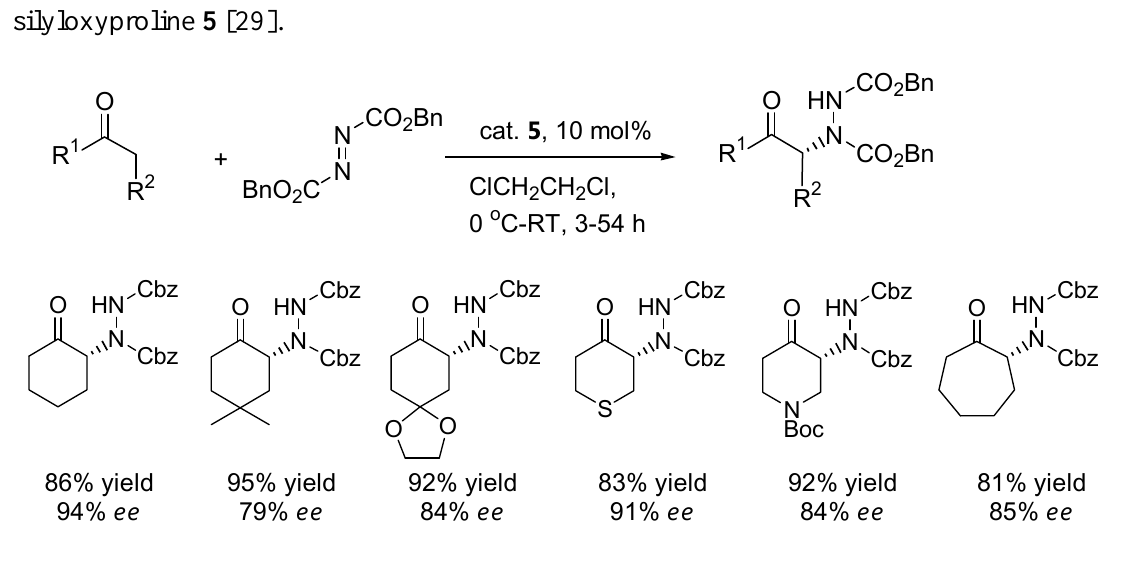
Figure 4. Additional non-amino acid catalysts for  -amination of